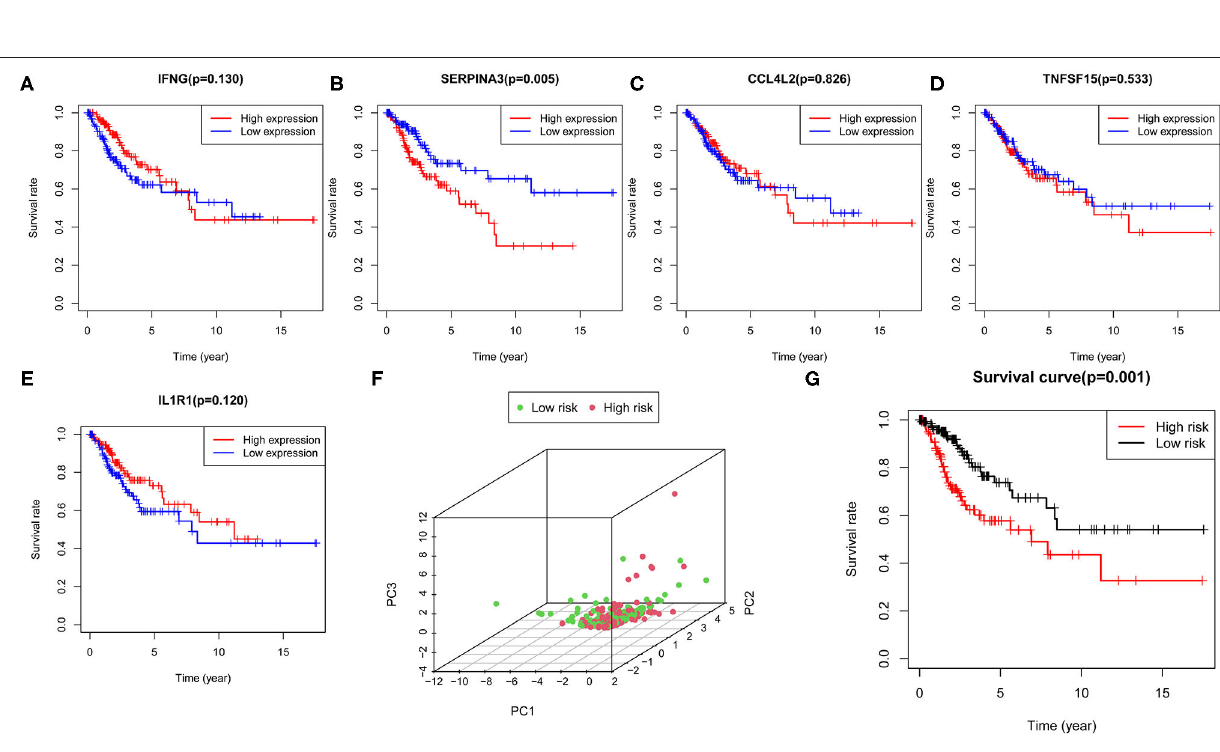
Frontiers in Medicine |